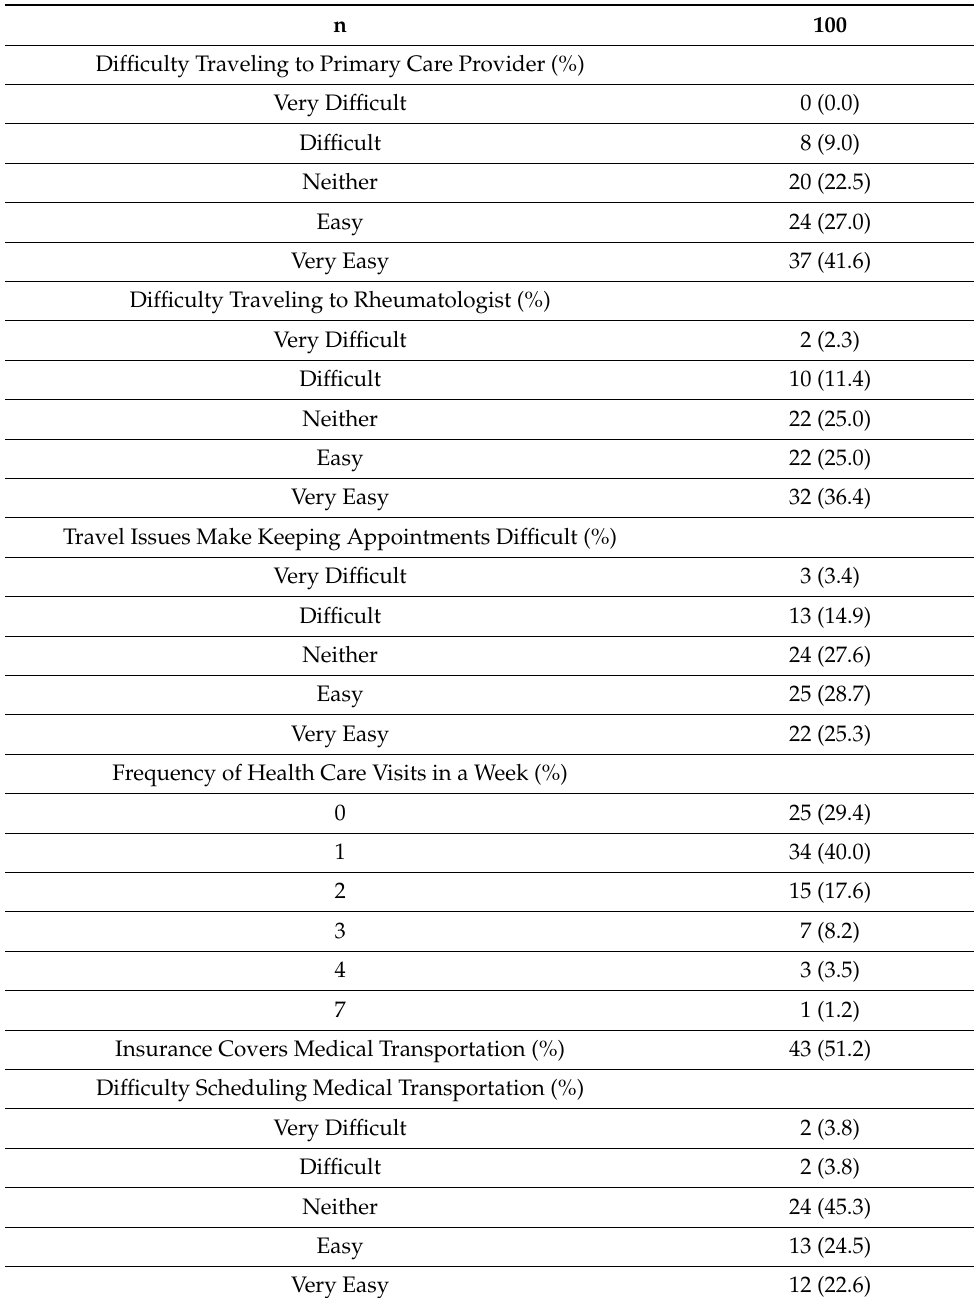
Table 2. Access to Healthcare and Travel Burden Characteristics. n 100 Difficulty Traveling to Primary Care Provider